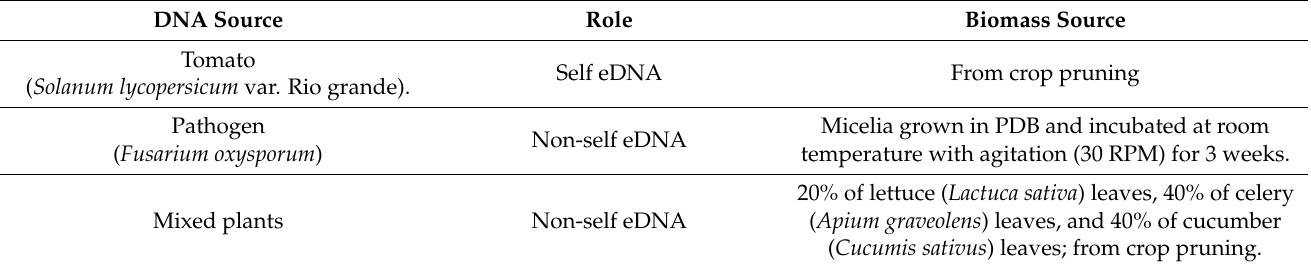
Table 1. Sources of DNA for